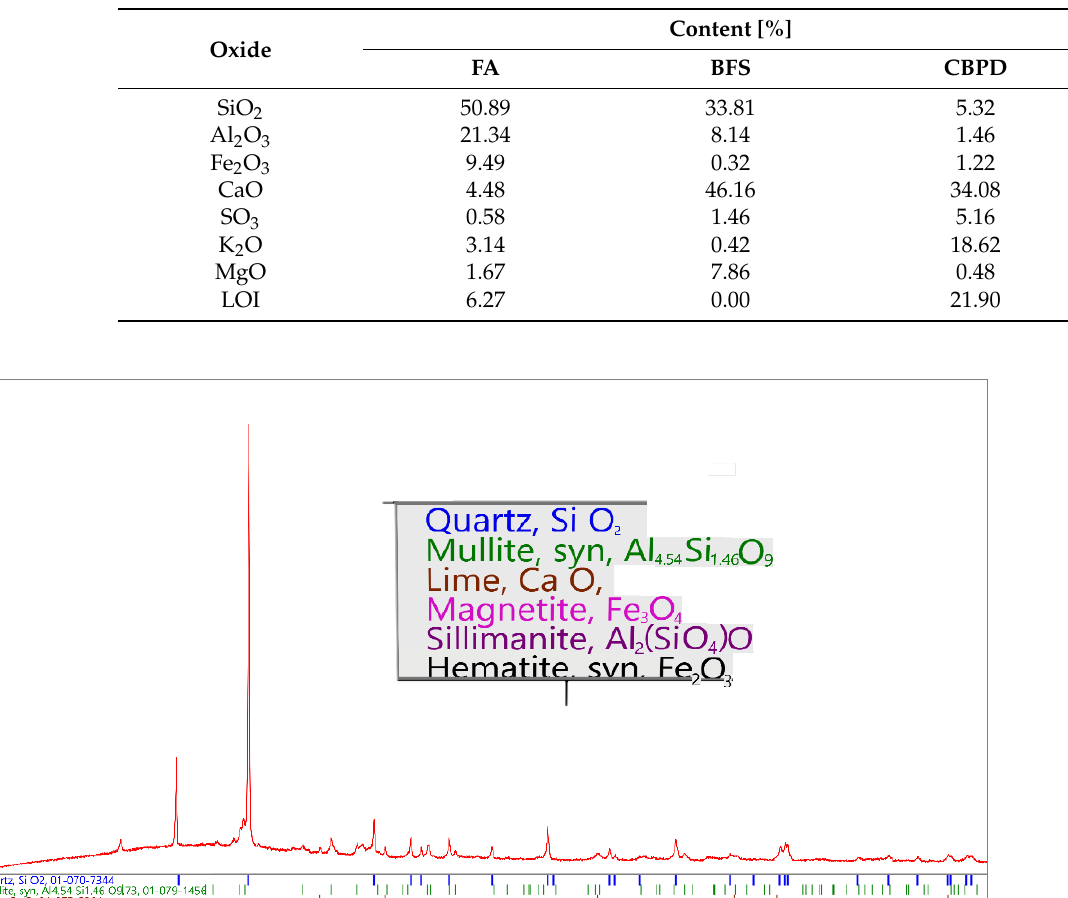
Table 1. Content of selected oxides in input raw materials. (FA—fly ashes, LOI—Loss on Ignition).